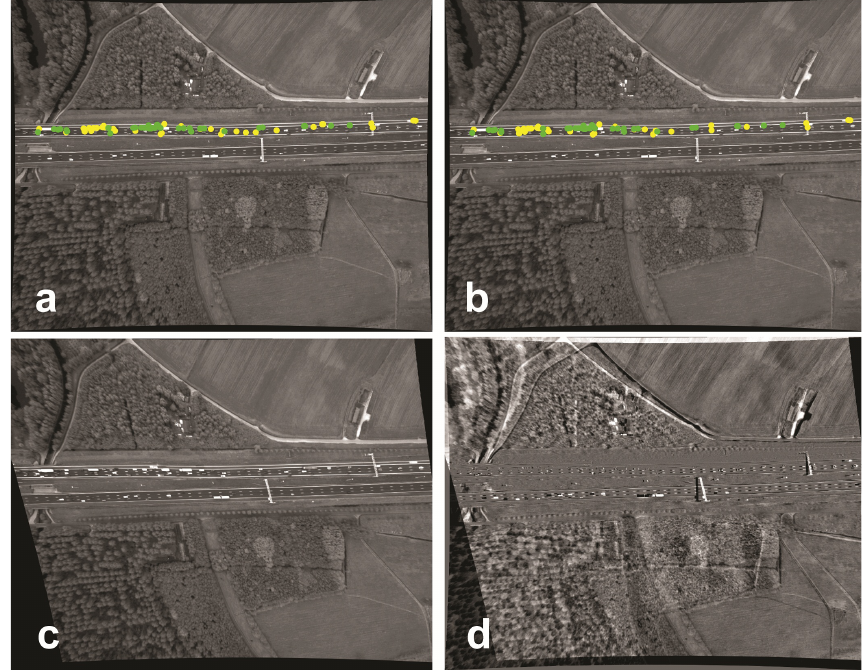
Figure 2. SIFT-based matching results for registration of Image b to Image a. ( a ) The first image of the image sequence; ( b ) the second image. The point colors, yellow and green, are, respectively, the corresponding points matched by SIFT (82) and the remaining corresponding points (41) suitable for the homography matrix calculation; ( c ) The transformed Image b; ( d ) the difference between Image c and Image